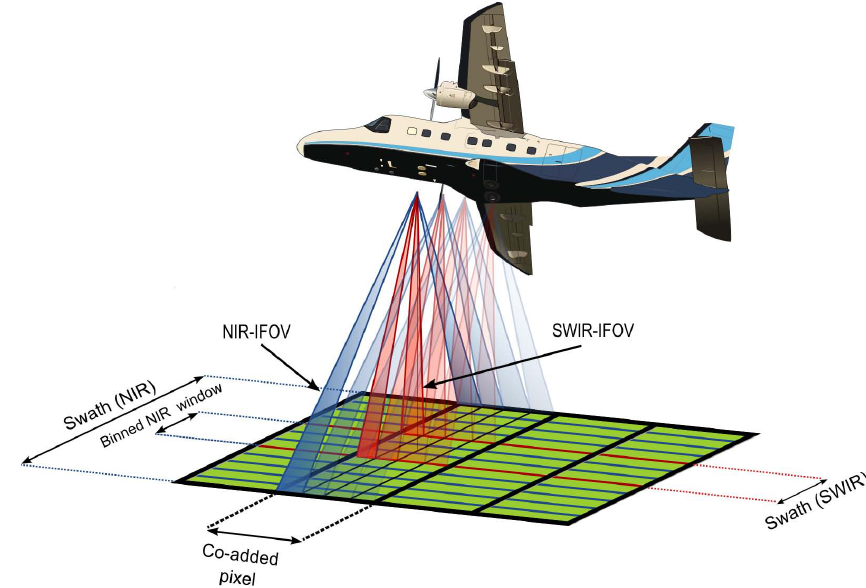
Fig. 3. MAMAP observation geometry for the 1-D-SWIR (red) and the 2-D imaging NIR (blue)